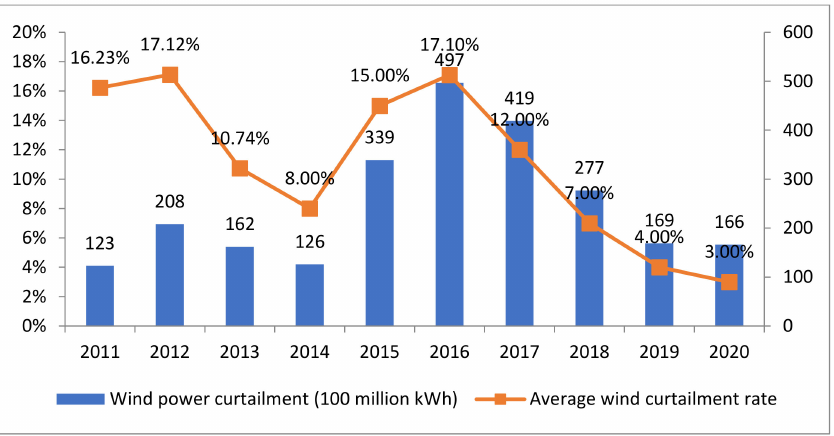
Figure 5. Average wind curtailment rate and power in China. (Data source: National Energy